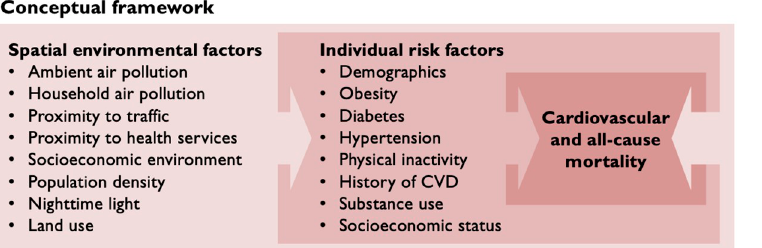
Fig 1. Conceptual framework. Impact of eight SEFs on individual risk factors and CV and all-cause